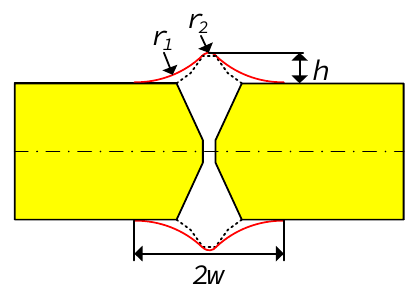
Figure 5. Schematic diagram of the three-tangent-circle methods.